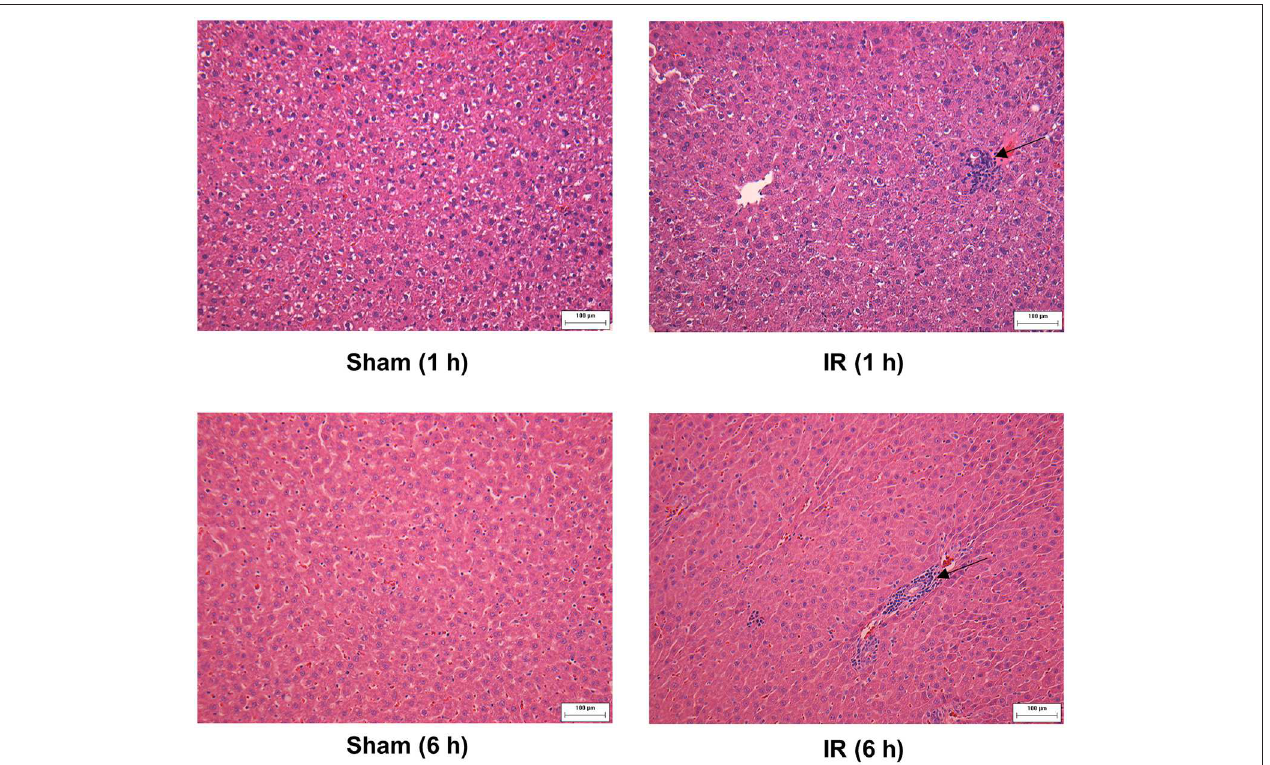
FIGURE 8 | Effect of kidney ischemia-reperfusion on pathohistological change of the liver. The left kidney of rats was subjected to 45min ischemia followed by 1 hour (1h) or 6 hours (6h) of reperfusion (IR). As a control, rats were subjected to a sham-operation without inducing ischemia (Sham). The histological structure of liver was examined by hematoxylin and eosin (H&E) staining (magnification × 200). Arrows point to inflammatory foci (scale bar = 100 µ